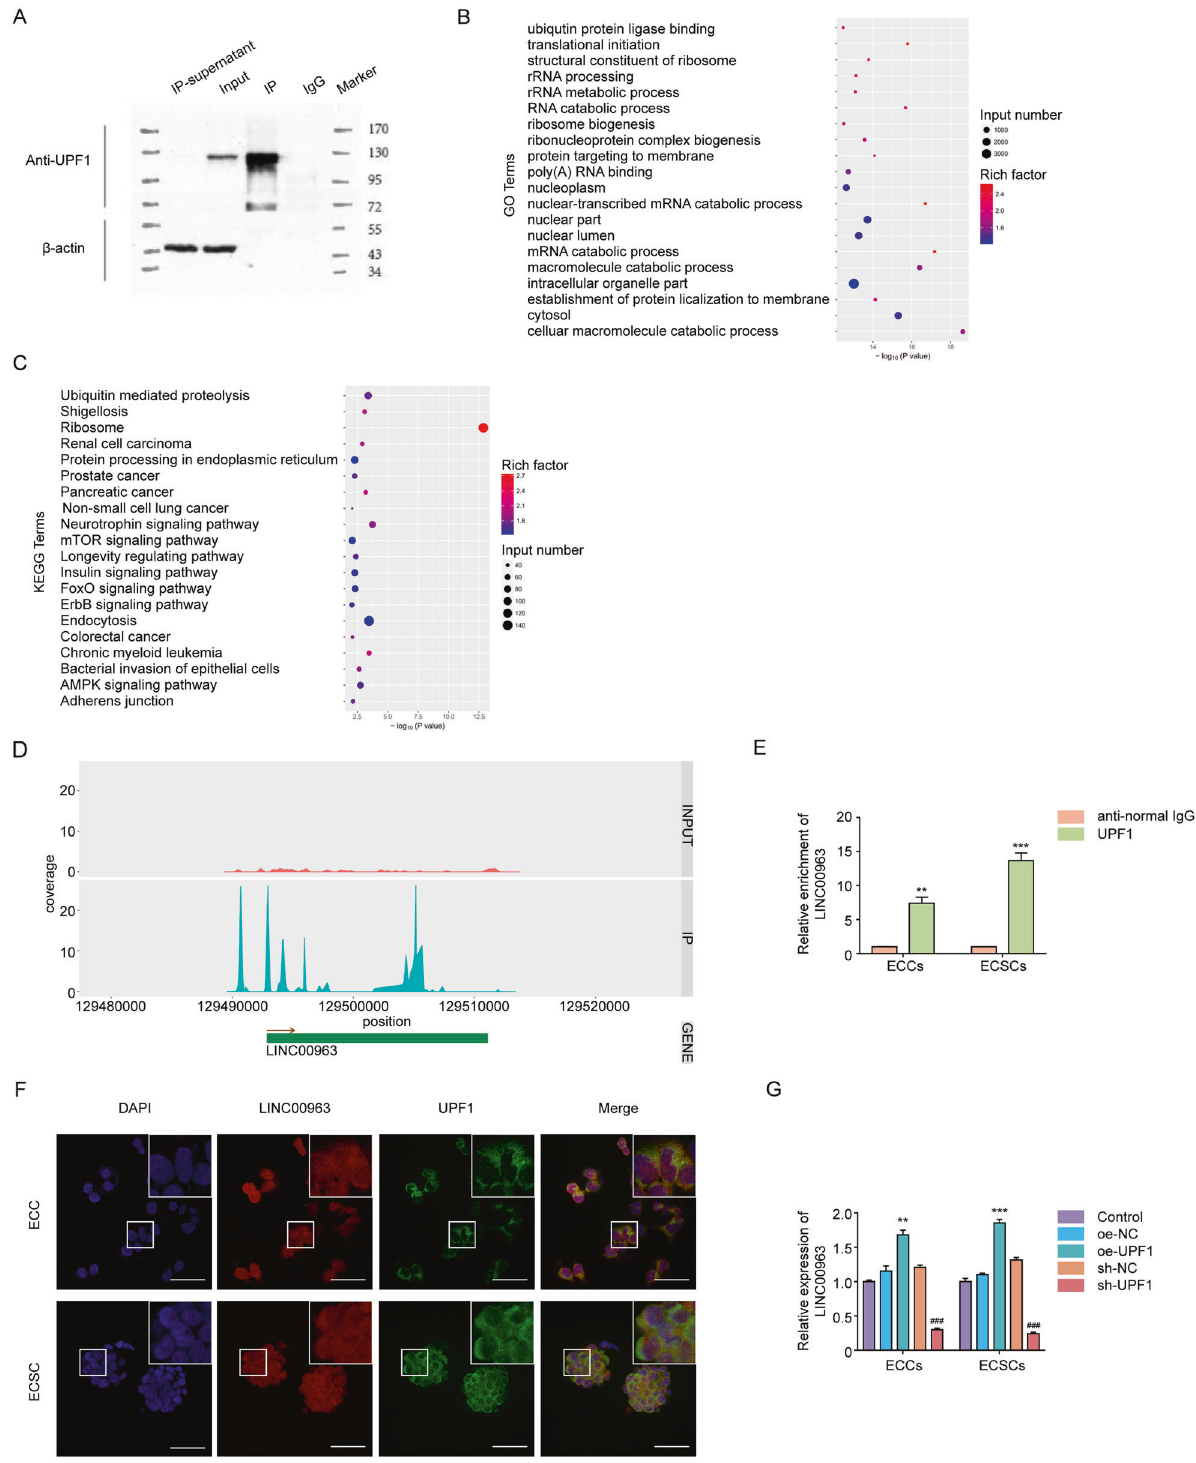
Fig. 3 UPF1 binds and positively regulates LINC00963. A Western blotting of UPF1 immunoprecipitation. B Top 20 upregulated GO and C Top 20 upregulated KEGG metabolic pathways of peak-associated genes. D Binding sites and enrichment of UPF1 and LINC00963. E Binding of UPF1 and LINC00963 determined using the RIP assay. F Co-localization of UPF1 and LINC00963 determined using RNA-FISH and IF. Data are presented as the means ± SEM, *** P < 0.001. G Effect of UPF1 overexpression or knockdown on LINC00963 expression assessed using qRT-PCR. Data are presented as the means ± SEM ( n = 3, each group), ** P < 0.01, *** P < 0.001 vs. oe-NC group, ### P < 0.001 vs. sh-NC group. Scale bars, 50 μ m.